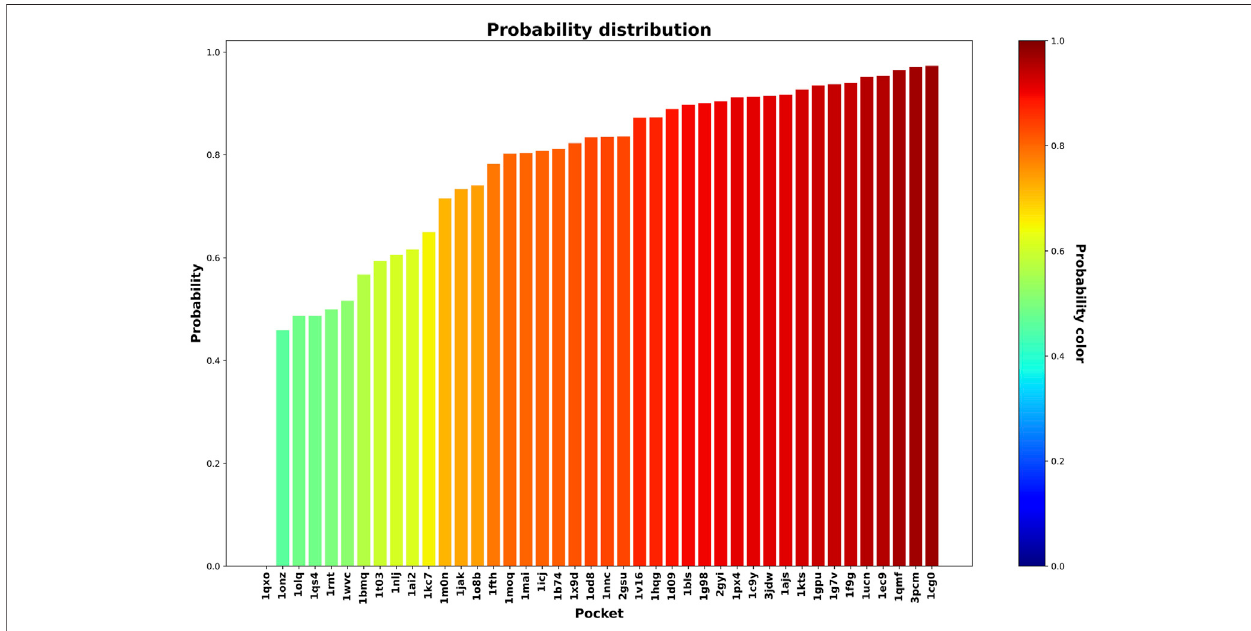
FIGURE 5 | Druggability prediction for the less druggable subset ofthe NRDLD dataset without adding hydrogen atoms. For each protein-binding site (the x -axis), we predicted its druggability probability (the y- axis and color of the bar).